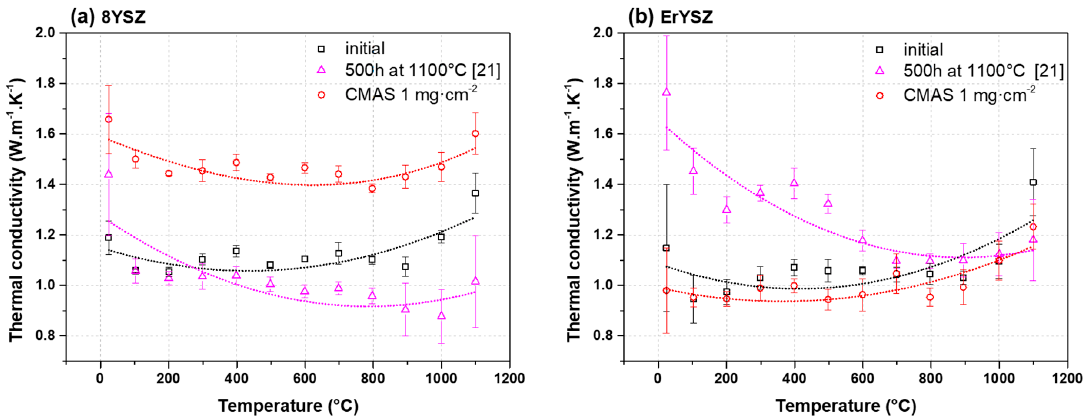
Figure 11. Thermal conductivity of ( a ) 8YSZ standard and ( b ) ErYSZ TBC systems in the initial condition and after CMAS attack with 1 mg·cm − 2 of CMAS deposit compared with aged coatings at 1100 °C for 500 h from previous work [21].